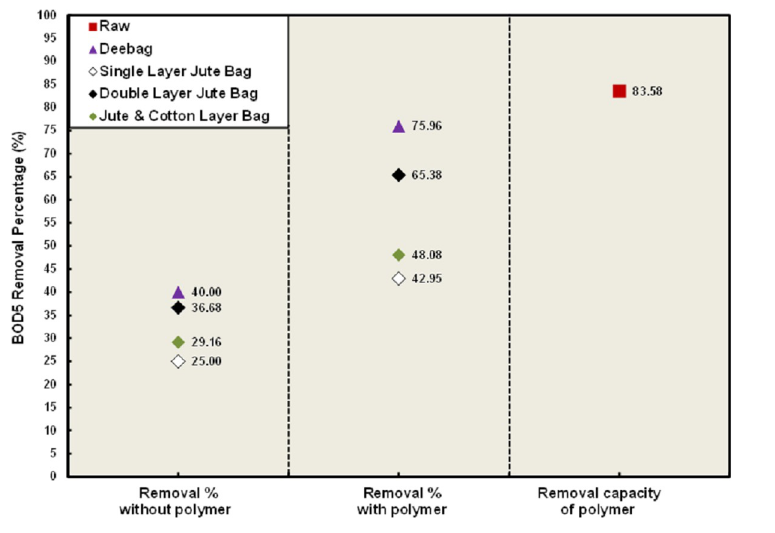
Fig 1. Removal percentages of BOD 5